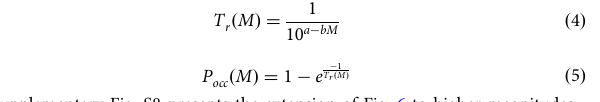
Scholz 52 , adapted to fi t the amplitude of the b -value observed in Basel (Fig. 1b 51 ): b ¼ 2 : 8 (cid:2) 0 : 02 σ diff ð 1 Þ Equation (1) was calibrated using the maximum amplitude of the b -value observed in Basel and fi tted to the range of differential stress in the modelled